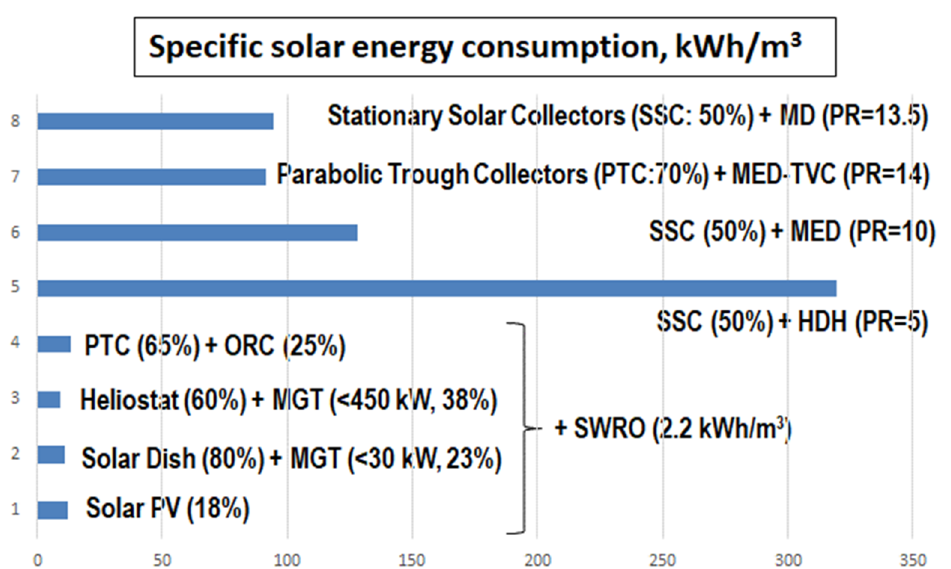
Figure 8. Comparison of solar desalination based on reverse osmosis and phase change desalination technologies. The estimation of the energy efficiency of solar energy technologies are given in brackets along with that of power cycles. The performance ratios of seawater distillation are reported in [106,107].